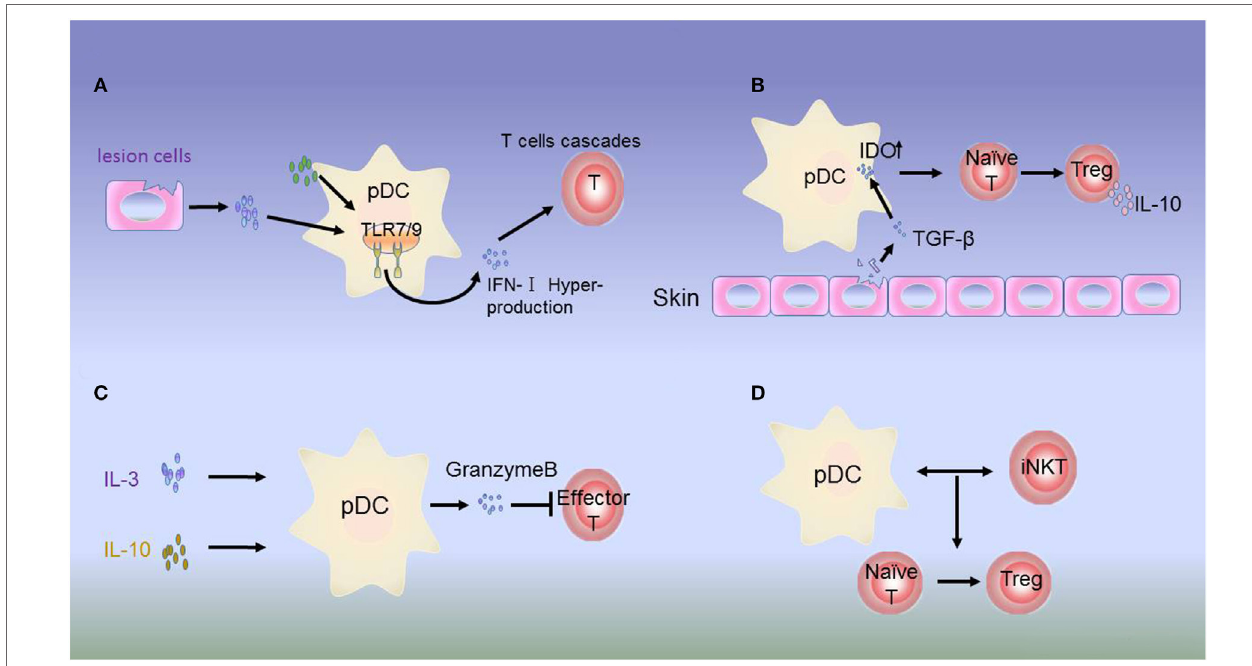
FigURe 2 | Dysregulation of plasmacytoid dendritic cells (pDCs) in autoimmune disease. (A) Hyperproduction of type 1 interferon (IFN-I) by pDCs. In psoriasis, systemic lupus erythematosus (SLE), and most autoimmune inflammations, constitutive expression of toll-like receptor (TLR)-7/9 leads to excessive activation of pDCs in the skin of patients by molecules from lesion cells or autologous pDCs. IFN-I produced by pDCs initiates abnormal production of T cells. (b) Immunosuppressive role of IDO. The inhibitory molecule IDO acts as a signaling protein in response to TGF- β , inducing the conversion of naive CD4 + and CD8 + T cells into Tregs. IDO can also dampen the antigen-presenting ability of pDCs. (C) In JIA, Tregs secrete low levels of IL-3 and IL-10. In response to these regulatory molecules, pDCs produce granzyme B to suppress the proliferation of effector T cells. (D) In type I diabetes (T1D), the interactions between pDCs and iNKT cells induce the T cells to differentiate into Foxp3 + CD4 + Tregs.